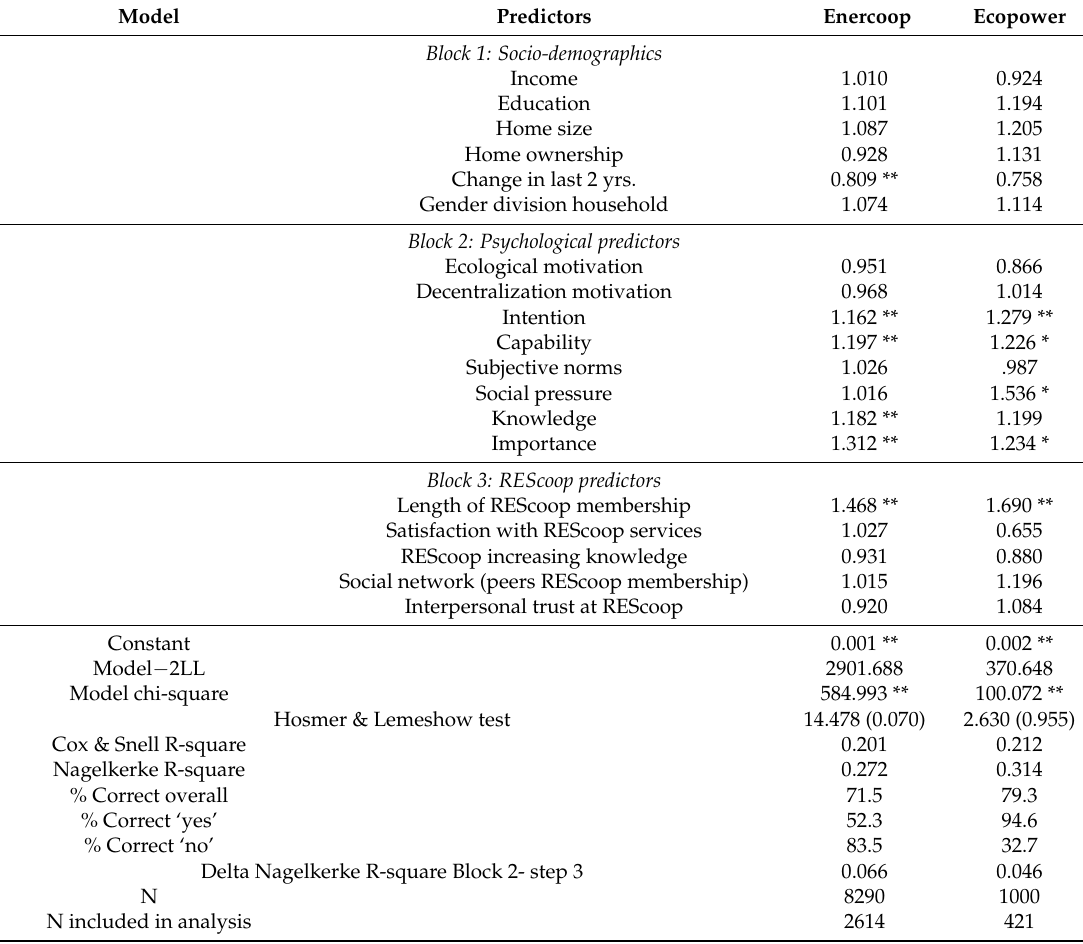
Table 10. Results of binary logistic regression analyses on self-reported energy savings since REScoop